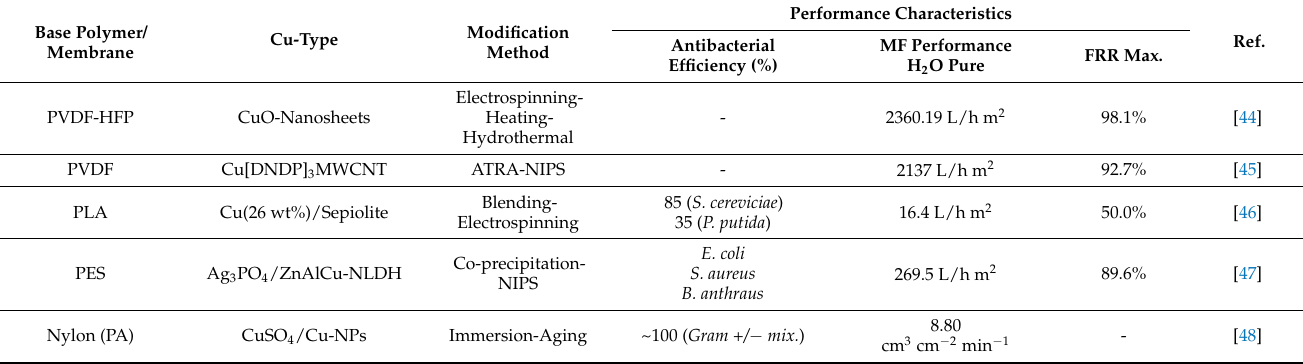
Table 6. Summary of MF membranes modified with copper-containing compounds. Performance Characteristics Modification Ref.Antibacterial Method Efficiency